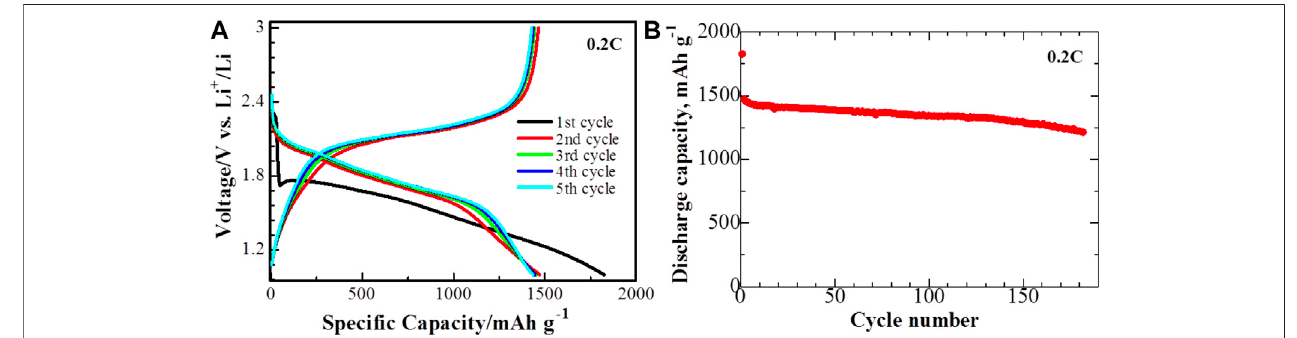
FIGURE 5 | (A) Charge/discharge pro fi les and (B) cyclability of S/PAN/KB full-cell at 0.2